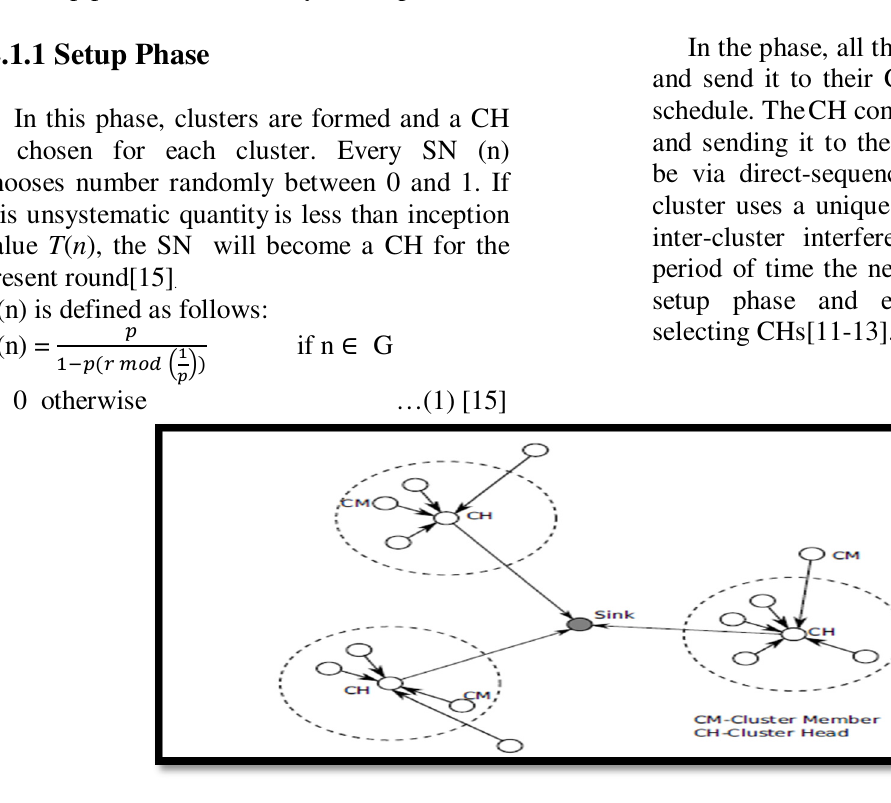
Fig. 3. LEACH protocol